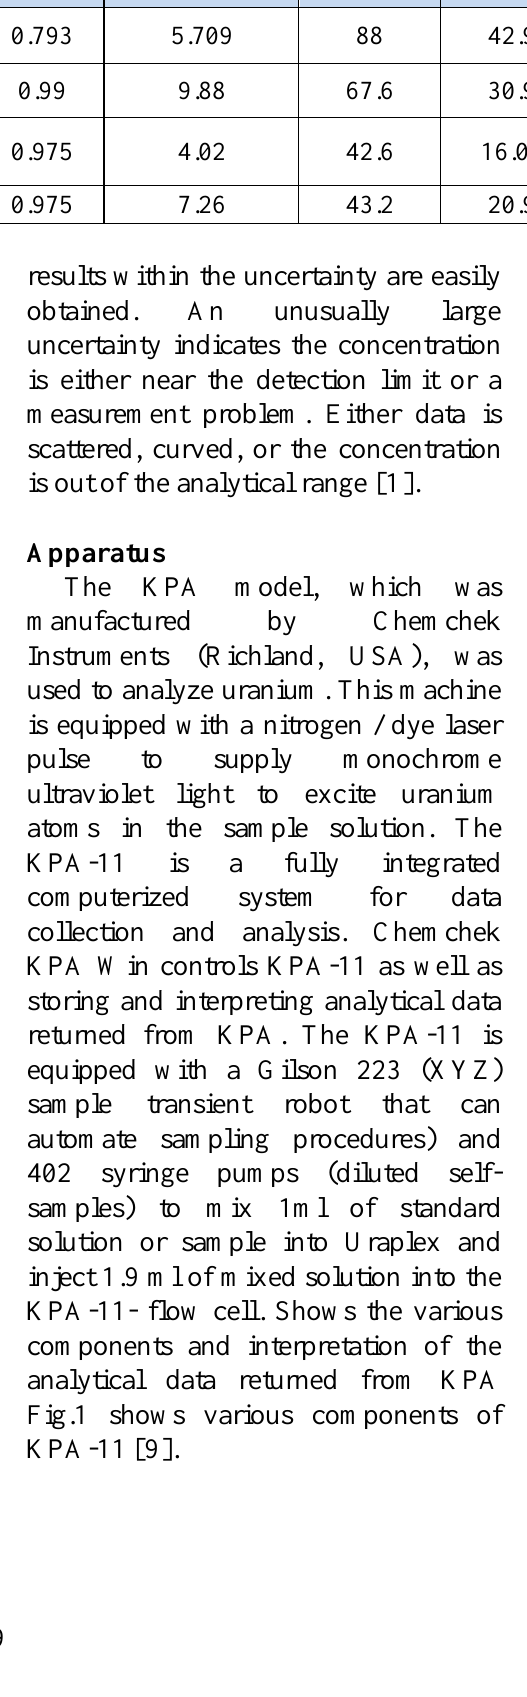
Table 2: The overall results of samples taken from the rain in Bagdad.